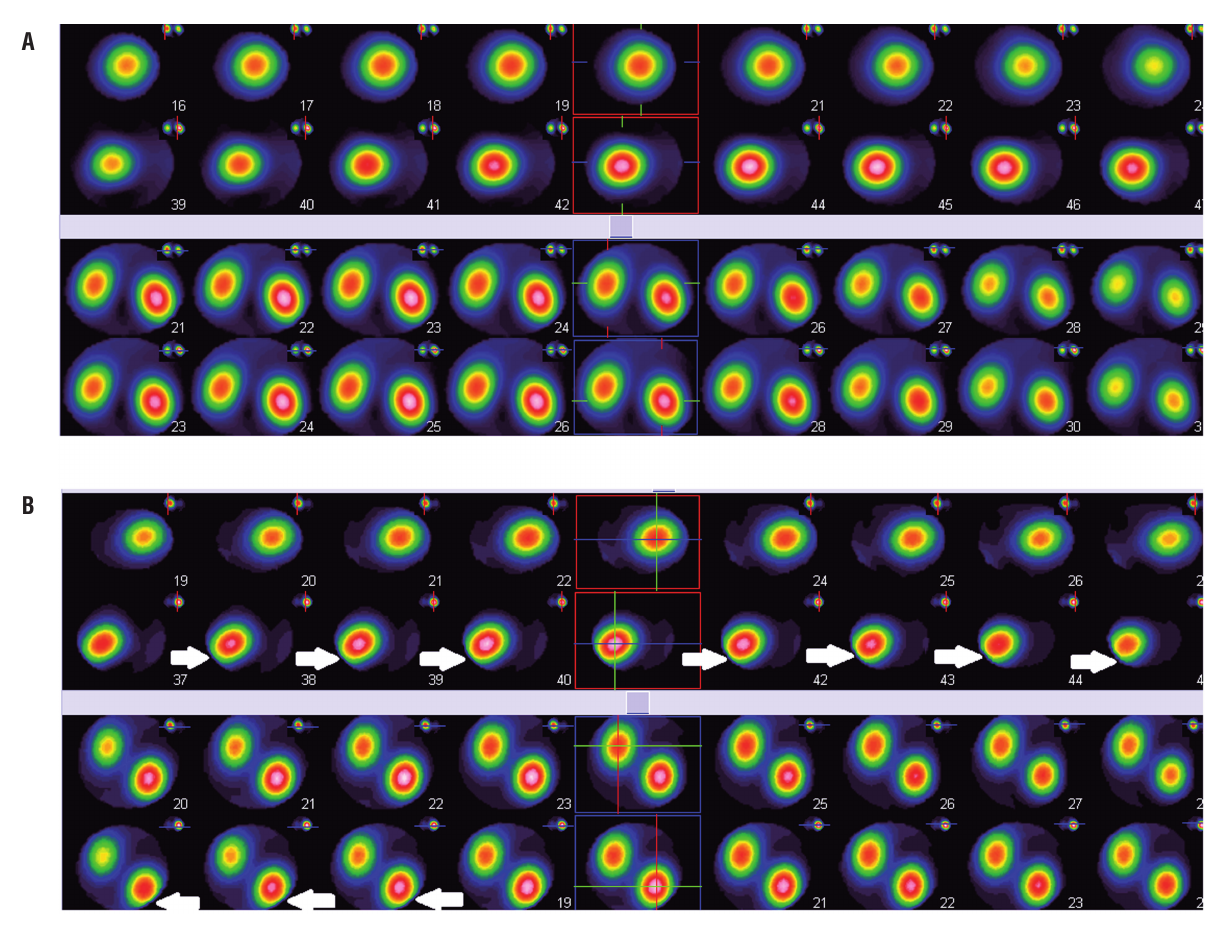
2 - (A) SpEcT in the experimental group three months after delivery showed satisfactory results without any significant impairment as compared with control group; (B) SpEcT in the control group showed that the renal injury persisted after three months of damage induction. The arrows demonstrate the damage in several sections while such impairment was not detected in experimental